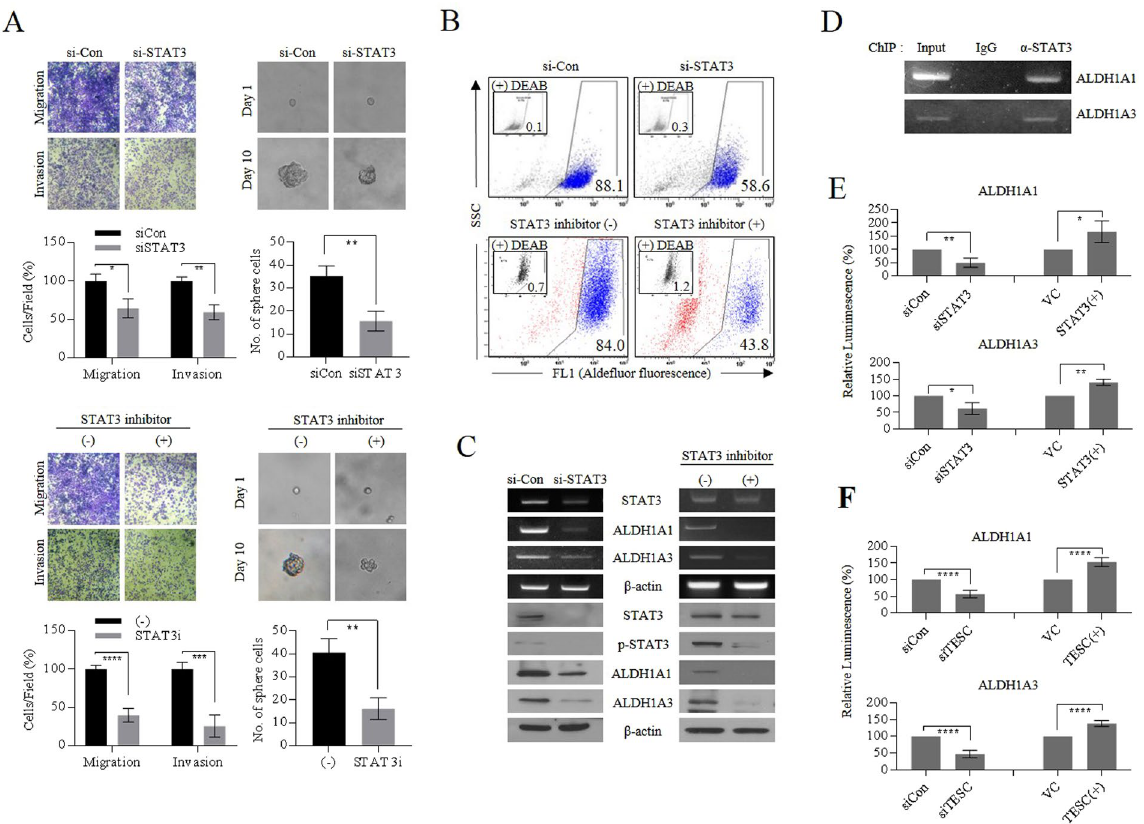
Figure 6. TESC is involved in the transcriptional regulation of ALDH1 expression by STAT3. ( A ) Changes in EMT properties and spheroid formation in STAT3 -knockdown A549 cells with siRNA or STAT3-inactivated A549 cells treated with STAT3 inhibitor VII (10 μ M) for 24 h. ( B ) FACS analysis of ALDH1 isozymes expression in STAT3 -knockdown A549 cells or A549 cells treated with STAT3 inhibitor VII. FACS analysis of ALDH1 expression was performed using ALDEFLUOR assay kit. ( C ) RT-PCR and Western blot analysis of ALDH1 isozymes in STAT3 -knockdown A549 cells or A549 cells treated with STAT3 inhibitor VII. ( D ) Detection of STAT3 binding in ALDH1 ( ALDH1A1 and ALDH1A3 ) promoter regions by chromatin immunoprecipitation (ChIP) assay in A549 cells. For negative control normal mouse IgG was used. PCR was performed using primer sets of ALDH1A1-3 and ALDH1A3-4 with sequences in Table 1. ( E ) Luciferase reporter assay to evaluate the transcriptional activity of ALDH1 isozymes ( ALDH1A1 and ALDH1A3 ) by knockdown or overexpression of STAT3 . ( F ) Luciferase assay of ALDH1 expression by knockdown or overexpression of TESC . Data represent mean ± SD using two-tailed t-test. * P < 0.05; ** P < 0.01; *** P < 0.001, and **** P <